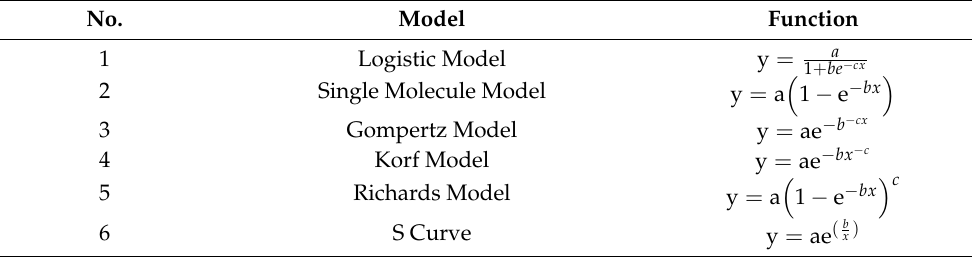
Table A2. Six theoretical forest age-stand